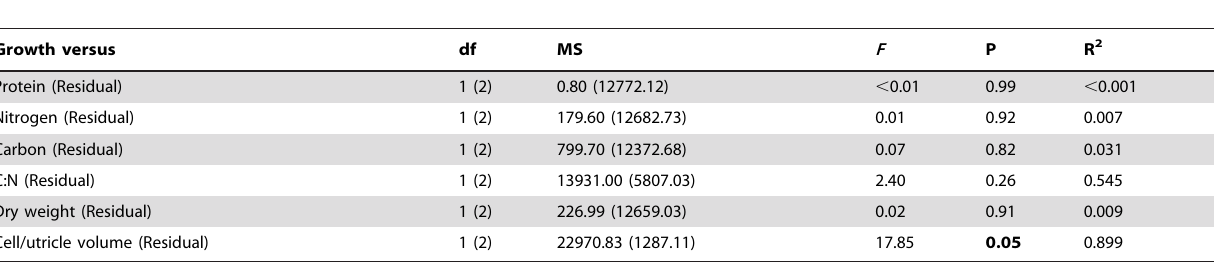
Table 2. Simple linear regressions of mean Elysia viridis growth (mg) versus the mean protein content (% dry weight), nitrogen (N) content (% dry weight), carbon (C) content (% dry weight), C:N ratio, dry weight (% of wet weight), and cell/utricle volume (nl) of different algal diet species in different weeks during the growth